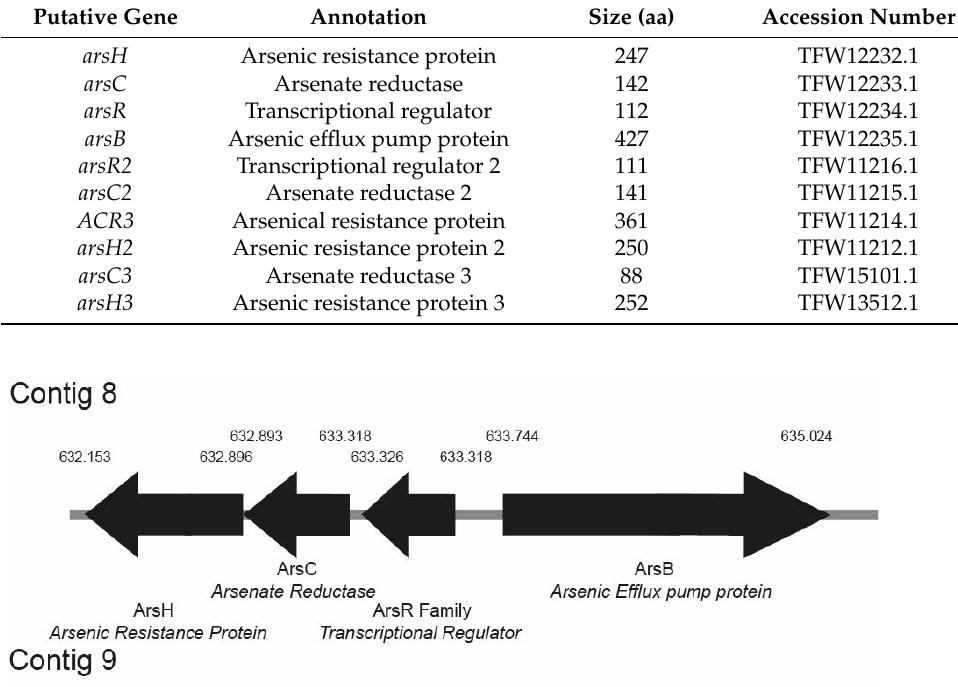
Table 4. List of heavy metal resistance-related genes found in Brevundimonas sp. B10.